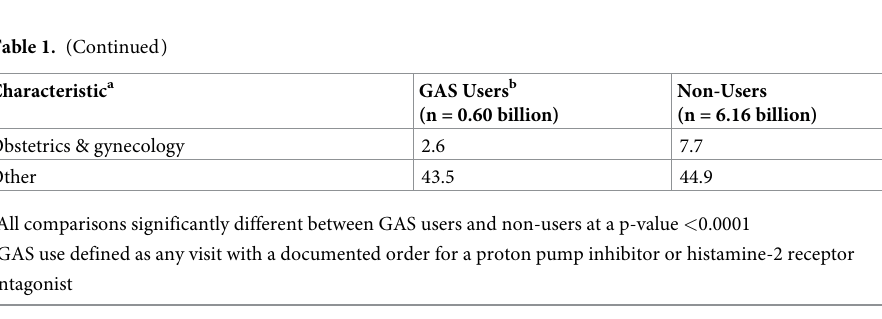
PLOS ONE | https://doi.org/10.1371/journal.pone.0208461 November30,